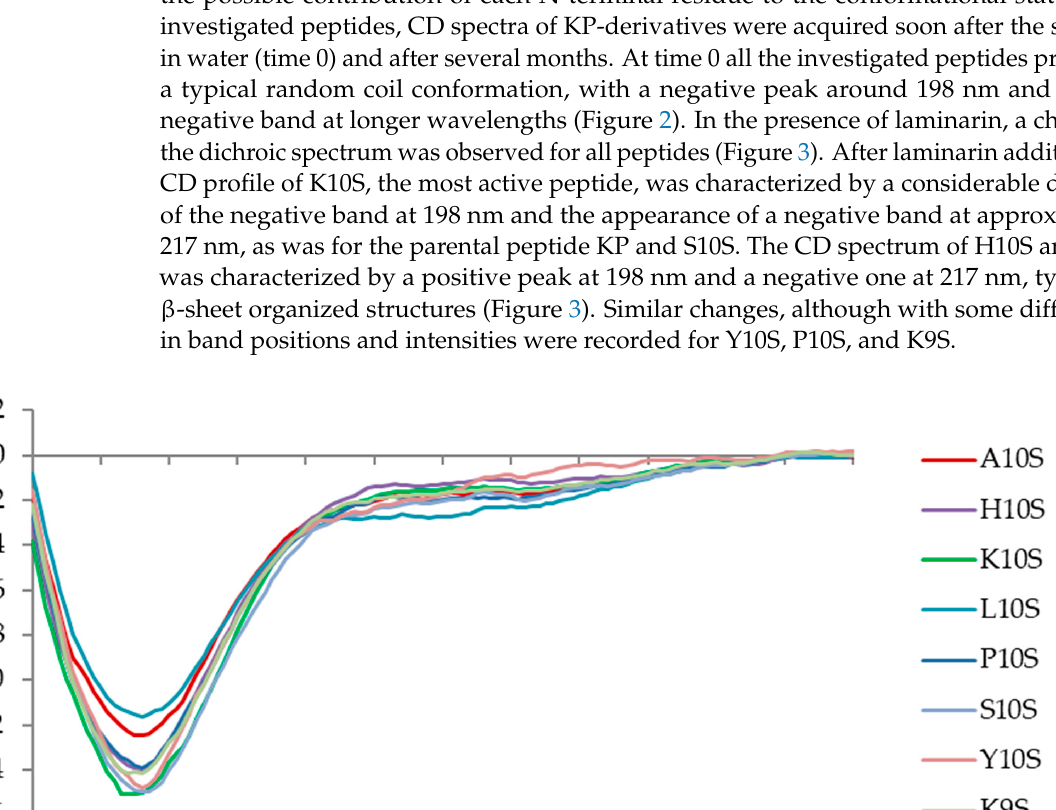
Figure 3. Far UV-CD spectra of 100 µM KP (A10S) and KP-derivatives acquired at 20 °C in the presence of laminarin (500 µM) immediately after preparation of the starting aqueous solution (1 mM). Figure 4. Far UV-CD spectra of 100 µM KP (A10S) and KP-derivatives acquired at 20 °C 24 months after preparation of the starting aqueous solution (1 mM).